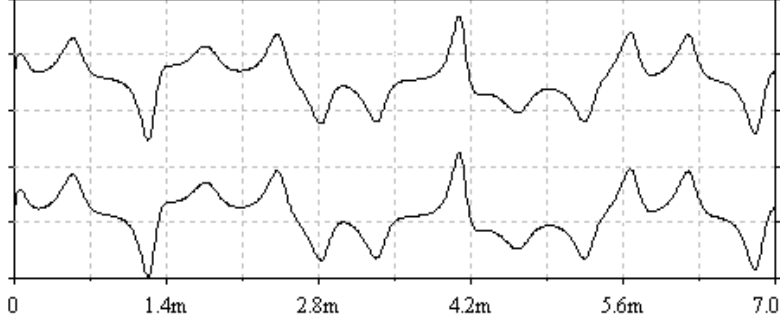
Figure 15. Comparison of synchronous signal waveforms (0.7 ms/div, 1